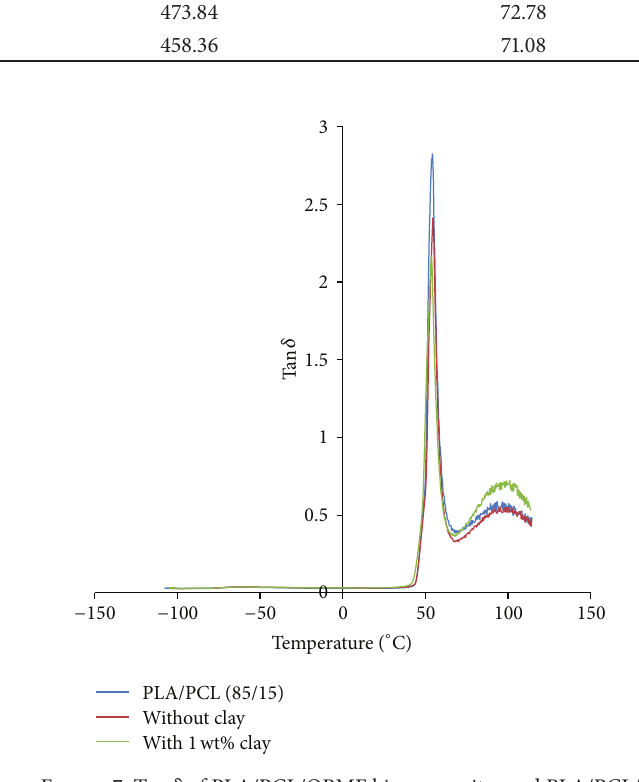
Figure 7: Tan 𝛿 of PLA/PCL/OPMF biocomposites and PLA/PCL/ 1wt% clay/OPMF hybrid